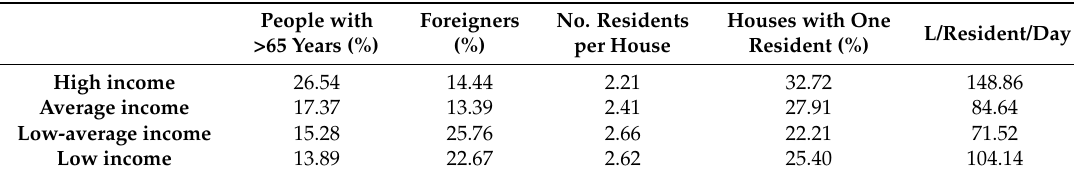
Table 3. Socio-economic characteristics of the districts of the urban core of Alicante, 2011. Source: INE, 2011.